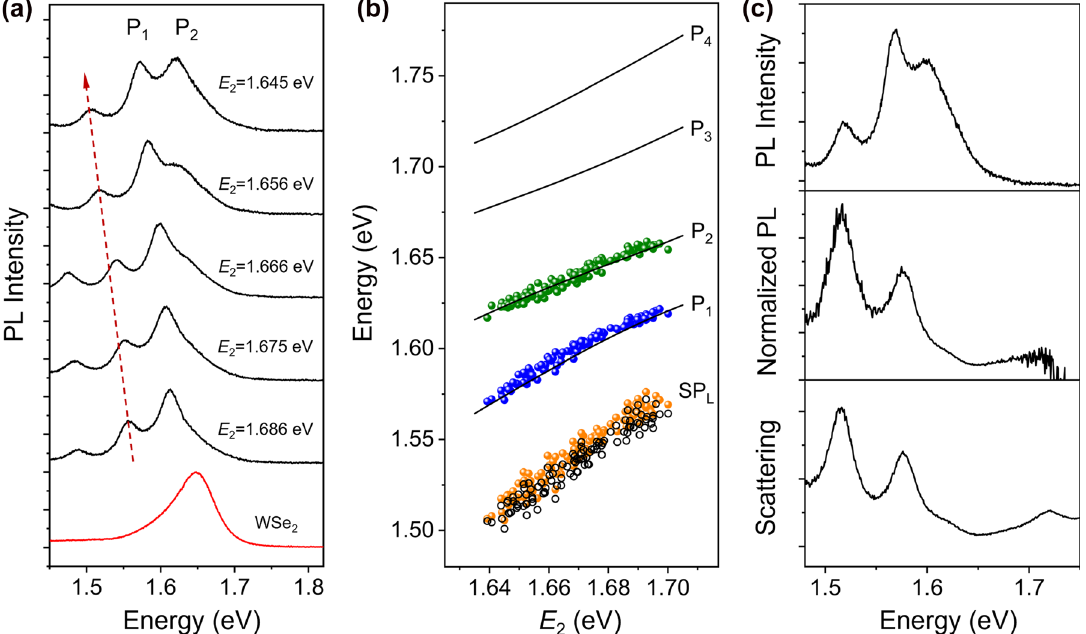
Figure 3: Analyses of PL spectra for Ag NW-WSe coupled systems. (a) PL spectra of Ag NWs on monolayer WSe with different E . The red arrow 2 2 2 mode. The two plexciton peaks are labeled as P and P . The PL spectrum of bare monolayer WSe without Ag NW is plotted marks the redshift of SP L 1 2 2 (orange, blue, and green dots). The black lines are the at the bottom. (b) Energies of fitting peaks in the experimental PL spectra as a function of E 2 mode extracted from the corresponding scattering calculated results for the scattering in Figure 2b. The black hollow dots are the energies of SP L = 1.650 eV). Middle: normalized PL coupled system when SP mode is close to exciton energy ( E spectra. (c) Top: PL spectrum for a Ag NW-WSe 2 2 2 spectrum resulting from dividing the top spectrum by the PL spectrum of bare WSe . Bottom: scattering spectrum for the same coupled 2